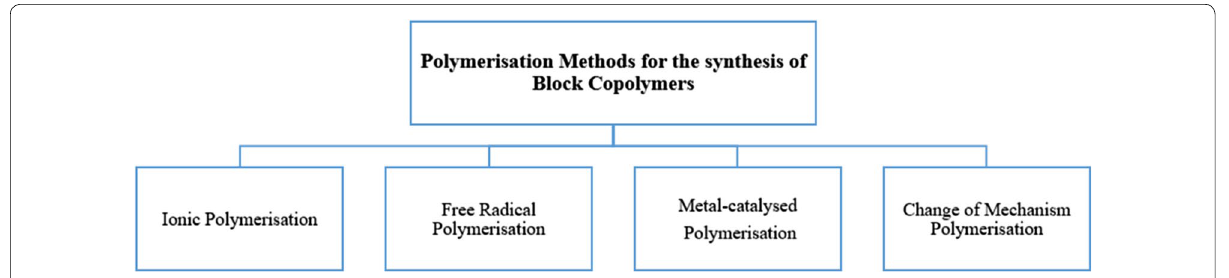
Fig. 3 Polymerisation methods for the synthesis of block